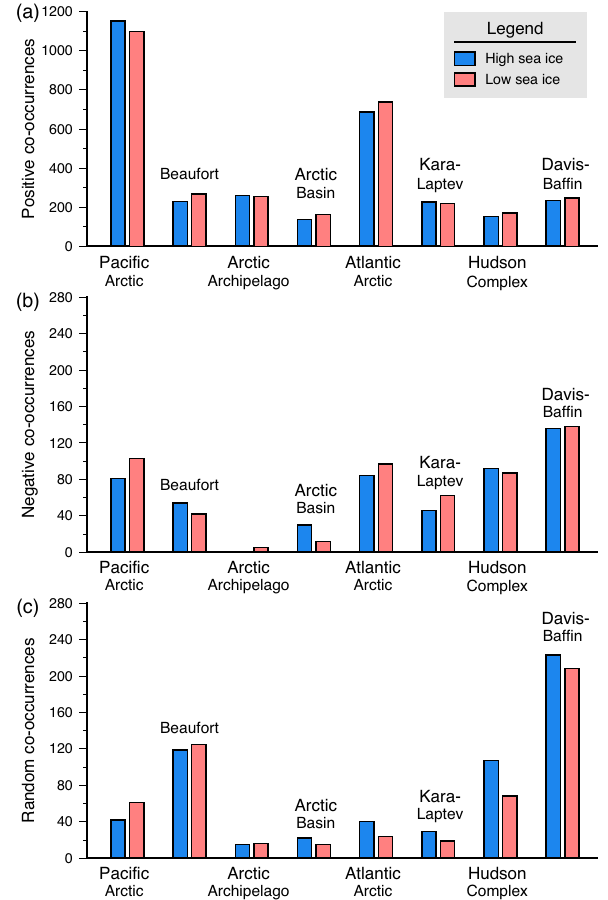
Figure 5. Frequency of ( a ) positive, ( b ) negative, and ( c ) random co-occurrences for all species across the different CBMP areas between periods of high and low summer sea ice conditions from 2000 to